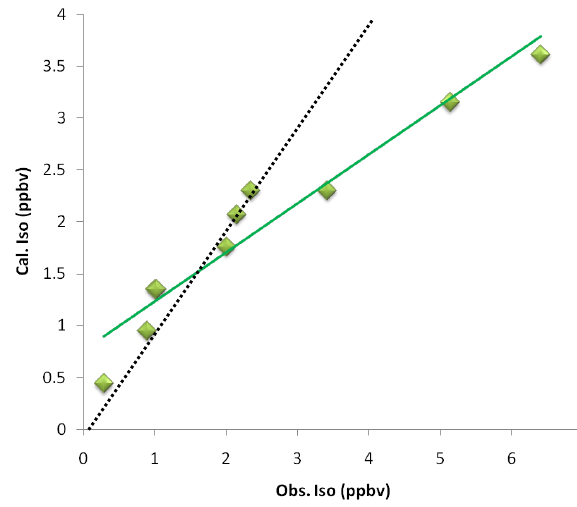
Figure 3, One by one comparison of the calculated and measured Fig. 3. One by one comparison of the calculated and measured isoprene concentrations. The green line is the fitting line of all the points, isoprene concentrations. The green line is the fitting line of all the points, and the black dot line is the 1:1 line between the calculations and the black dot line is the 1:1 line between the calculations and the and the measurements.